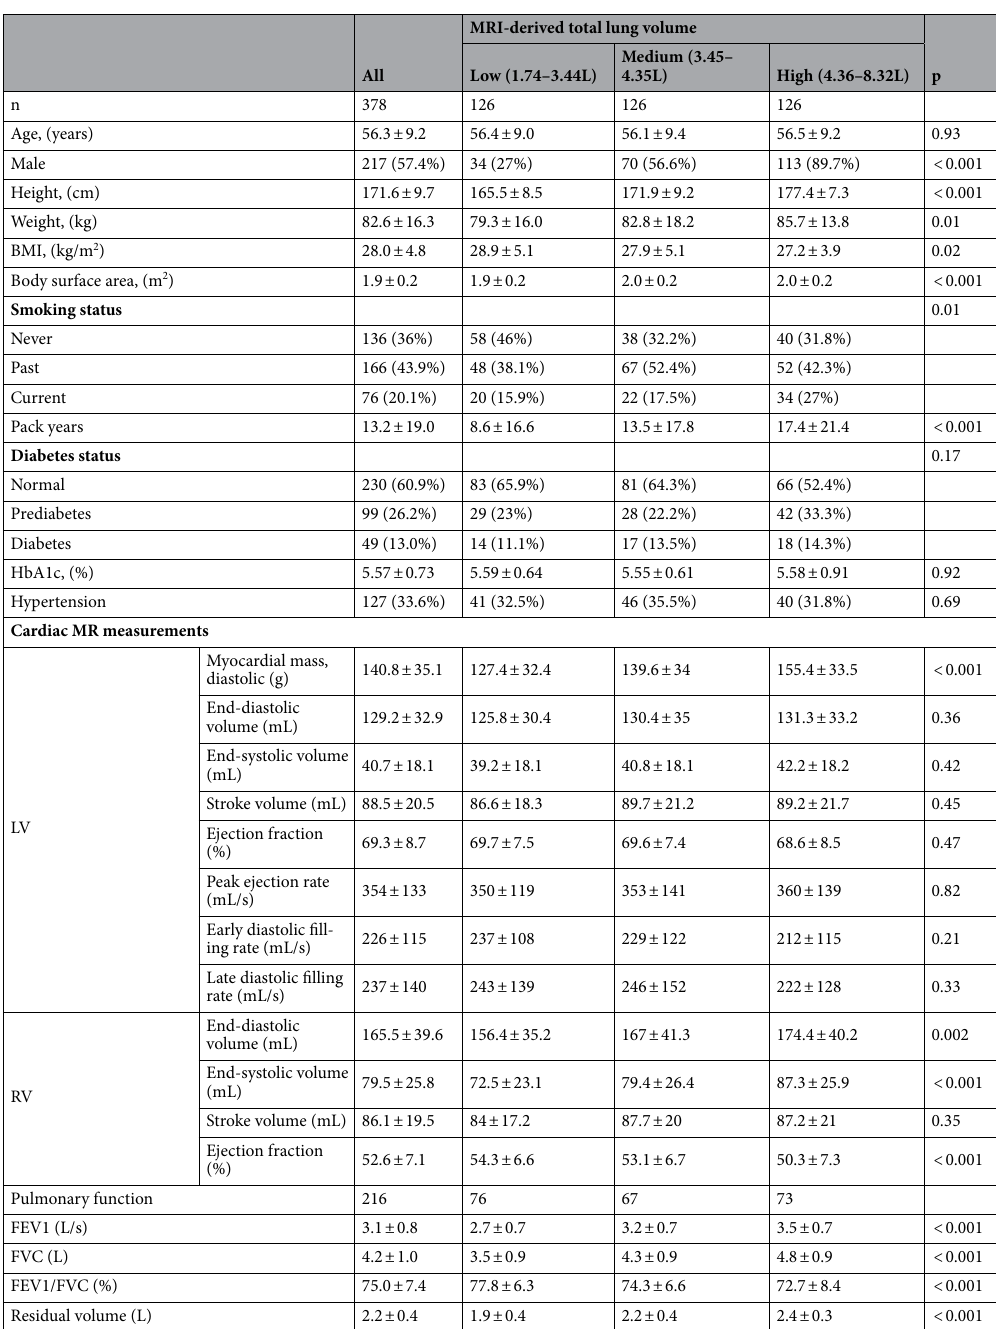
Table 1. Characteristics of the study population. The subjects were stratified in tertiles (denoted as low, medium and high) of MRI-derived Total Lung Volume. Pulmonary function test (PFT) was available in a subgroup of 216 subjects. The values represent mean ± standard deviation (SD) or frequency along with percentage. P Represents p-value, BMI body mass index, HbA1c Glycated hemoglobin A1c, LV Left ventricle, RV right ventricle, FEV1 Forced expiratory volume in 1 s, FVC Forced vital